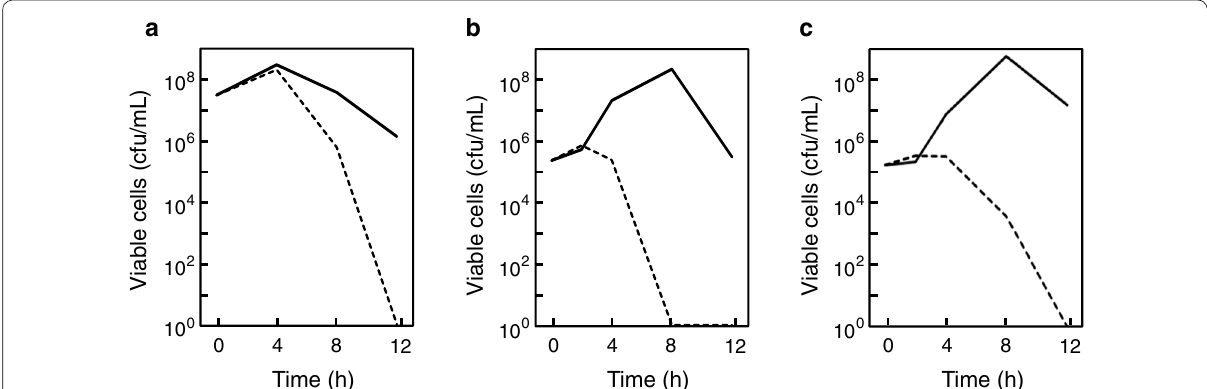
Fig. 3 Survival curves of S. pneumoniae strains in the presence and absence of the Natto peptide. a S. pneumoniae R6 cells were pre‑cultured to a cell density of approximately 10 7 cells/mL in TH broth containing 5% (v/v) horse hemolysate. The Natto peptide was then added at a concentration of 64 μg/mL. b , c S. pneumoniae R6 ( b ) and P103 ( lytA ‑deficient mutant derived from R6) ( c ) cells were suspended at a density of approximately 10 5 cells/mL in TH broth containing 5% (v/v) horse hemolysate. The Natto peptide was then added at a concentration of 64 μg/mL. Throughout the cultivation, the cultures were sampled, and culture aliquots were spread on a TH agar supplemented with 5% (v/v) horse hemolysate, and cultured for 24 h. Grown colonies were then counted. Dashed lines indicate cell numbers in the presence of the Natto peptide. Solid lines indicate cell num‑ bers in the absence of the Natto peptide. Each experiment performed at least three times, and the representative results are presented. The similar results were observed in the same experiments